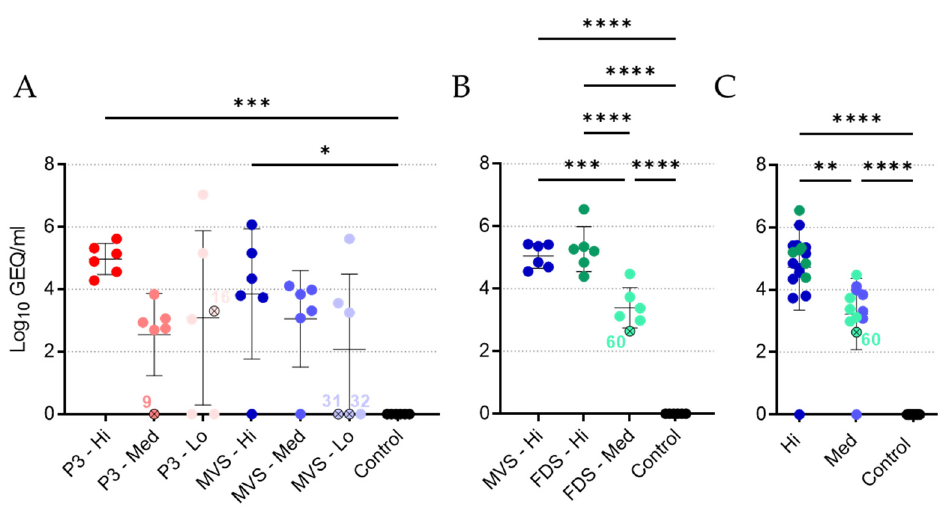
Figure 3. Vaccinemia following vaccination. Blood samples obtained from all guinea pigs at 2 days postvaccination (DPV) in Experiment #1 ( A ) or Experiment #2 ( B ) were assessed for levels of virus RNA via RT-qPCR. Data are presented as Log 10 genome equivalents (GEQ) per milliliter, with means and standard deviations for each group depicted behind individual values for each animal. Data from the high and medium dose levels for the PHV01 MVS and PHV01 FDS groups were pooled to assess dose-dependent effects ( C ). Vaccinated animals that did not survive infection are indicated with an “x” and labelled with the animal number. *, p ≤ 0.05; **, p ≤ 0.01; ***, p ≤ 0.001; ****, p ≤